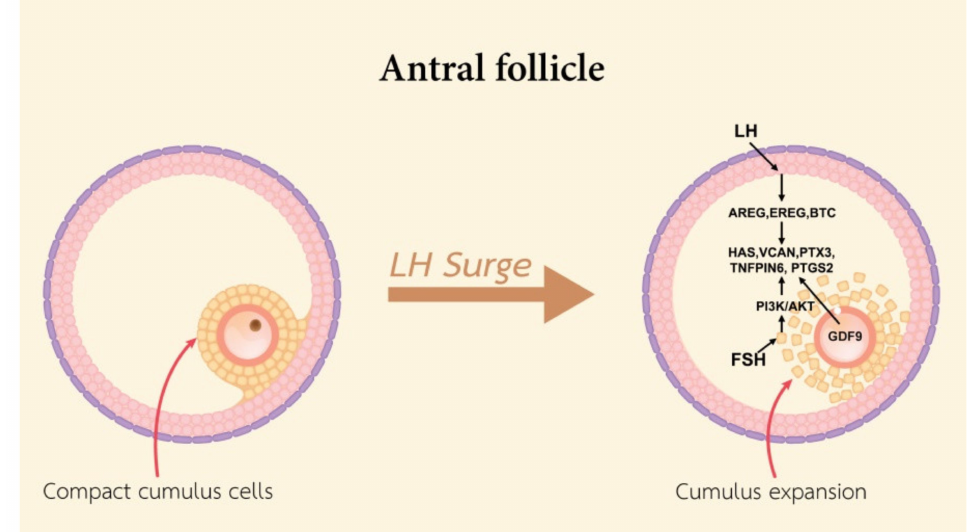
Figure 4. A schematic diagram exhibiting the functional roles of LH and FSH in stimulating cumulus